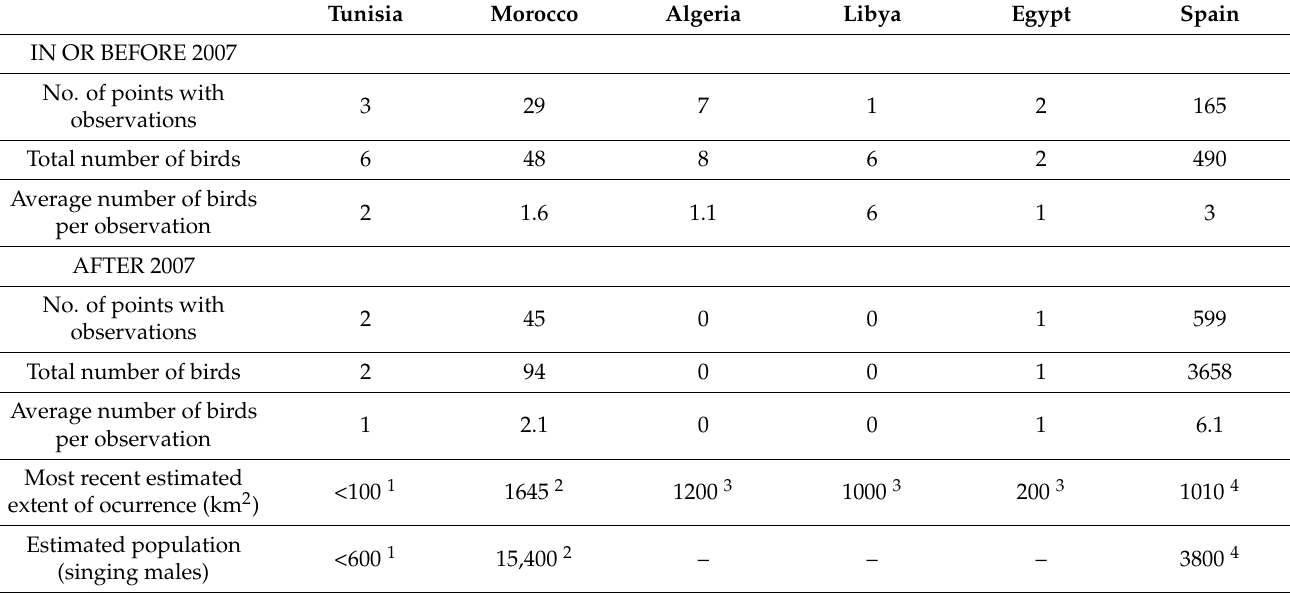
Table 2. Summary of Dupont ´ s lark observations uploaded to the E-Bird platform (revised on 10 January 2023). Data split by date as 2007 and years before and by years after 2007.